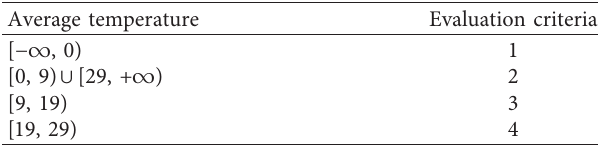
Table 3: Numerical table of average temperatures.